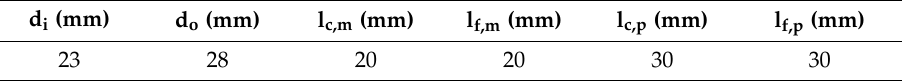
Table 3. Geometrical parameters of butt-bonded hollow cylinder specimens.